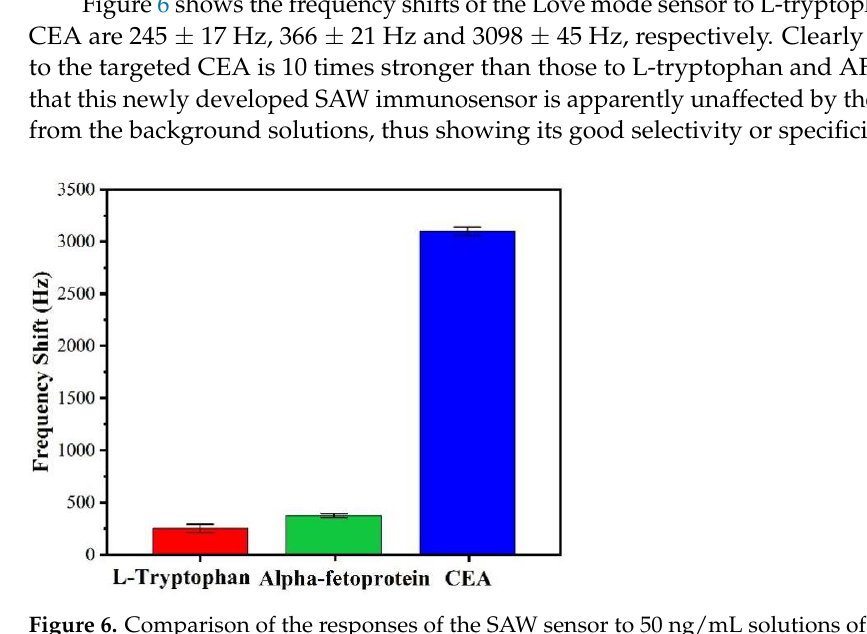
Figure 6. Comparison of the responses of the SAW sensor to 50 ng/mL solutions of L-tryptophan, Alpha-fetoprotein and CEA.